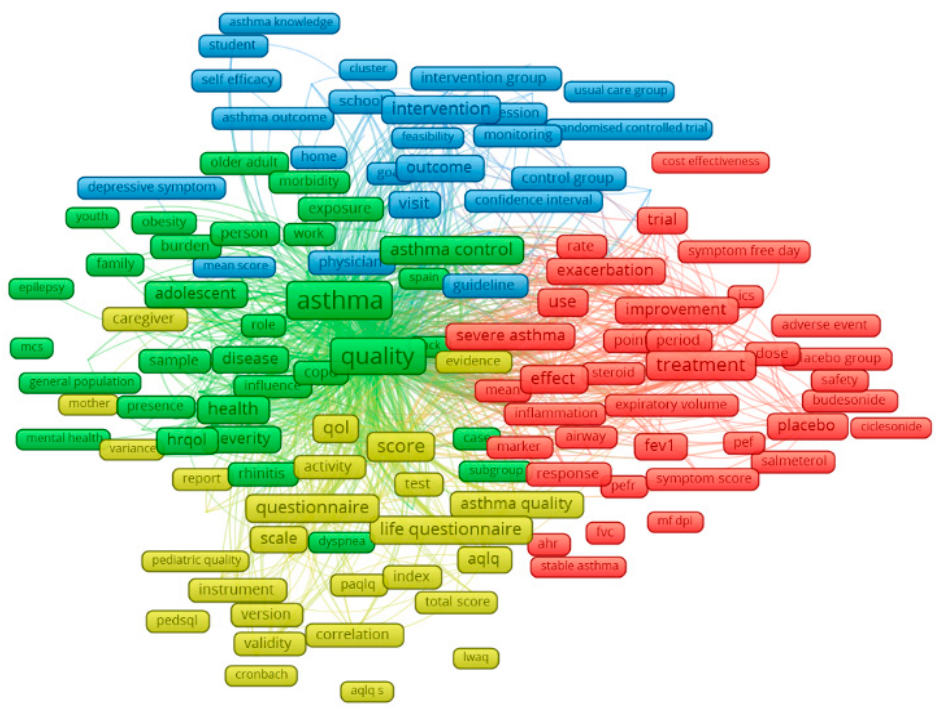
Figure 2. Co-occurrence of most frequent terms in titles and abstracts. Note: the colors of the nodes indicate principle components of the data structure; the node size was scaled to the keywords’ occurrences. Abbreviations: (red cluster) fvc—forced vital capacity, fev1—forced